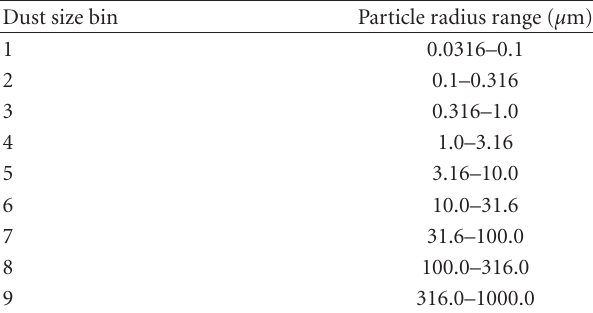
Table 1: Particle size ranges for each size bin taken from HadGEM2-A during this study. Further discussion and the deriva- tion of these values are given in